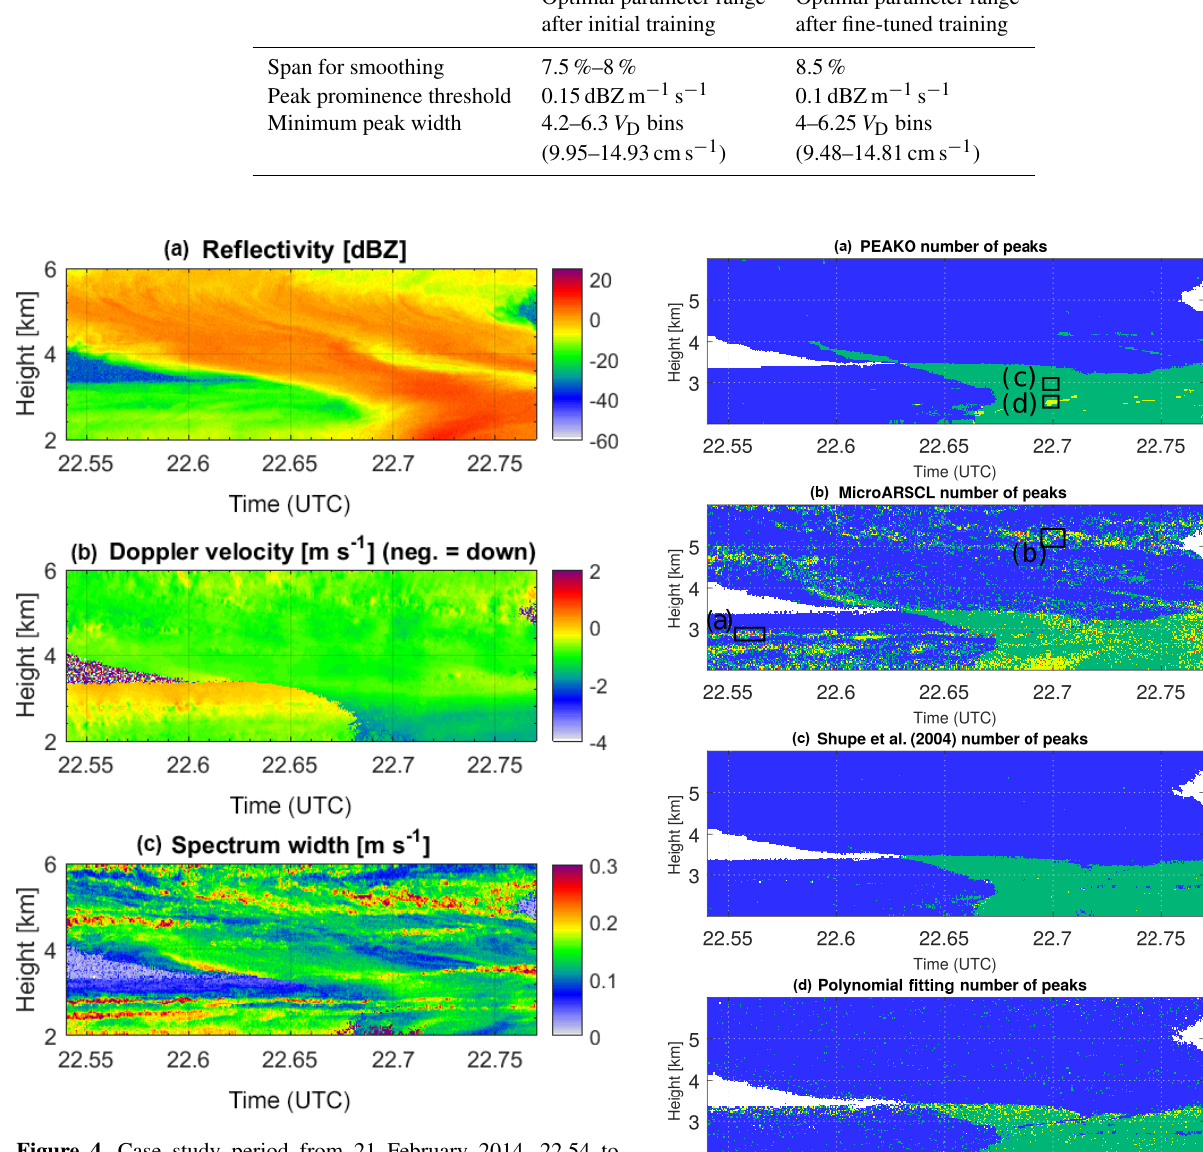
Figure 4. Case study period from 21 February 2014, 22.54 to 22.77UTC, at 2 to 6km height. Panels (a) , (b) , and (c) show the radar reflectivity factor Ze, the mean Doppler velocity (MDV), and the Doppler spectrum width σ of the main peak in the Doppler spec- trum. Figure 5. Number of Doppler spectrum peaks detected by different